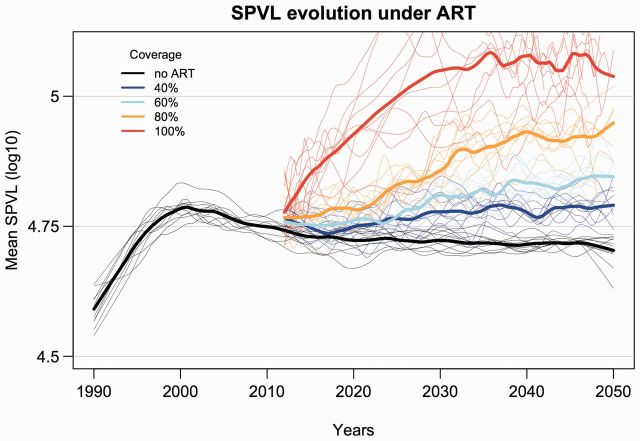
 Example simulated trends in HIV virulence (mean SPVL) for scenarios
of 40, 60, 80, and 100 percent coverage (individual probability of
treatment) and ART initiation at 3 years elapsed after infection,
versus the counterfactual simulation with no ART. Shown are LOESS
regression lines for ten random replicates for each ART coverage
scenario (thin lines), and the mean of these replicates (thick
lines). Initial mean SPVL was 4.5 log10 copies/ml. ART
coverage lines start at year 22, corresponding to a simulation
starting at year 1990 with ART rollout at year 2012.